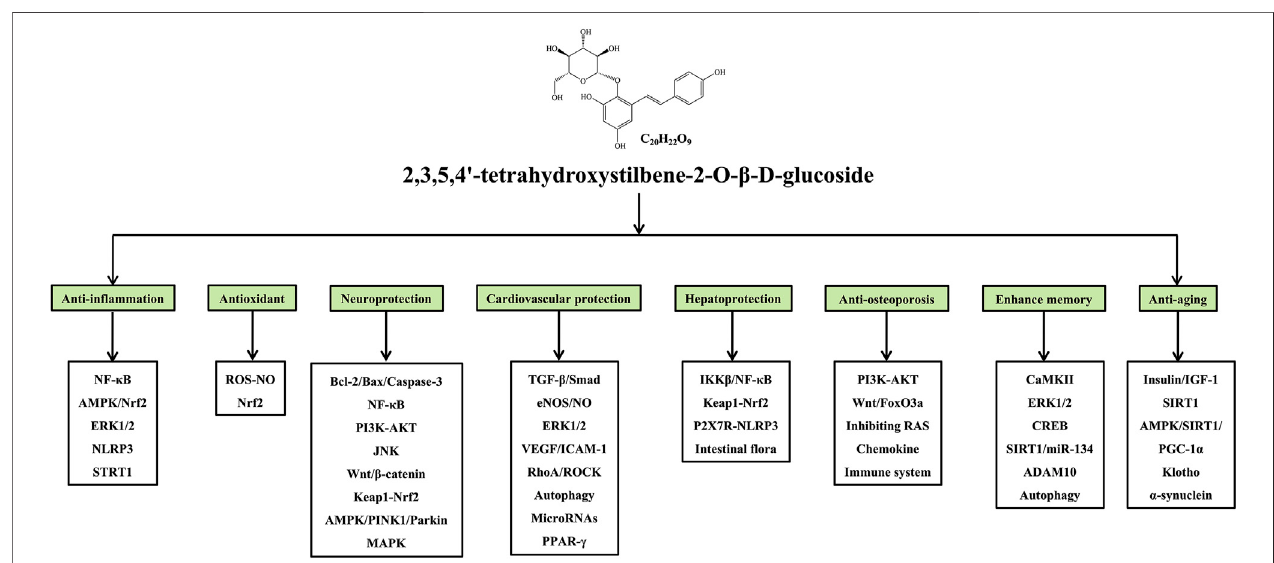
FIGURE 2 | Summary of pharmacological effects of